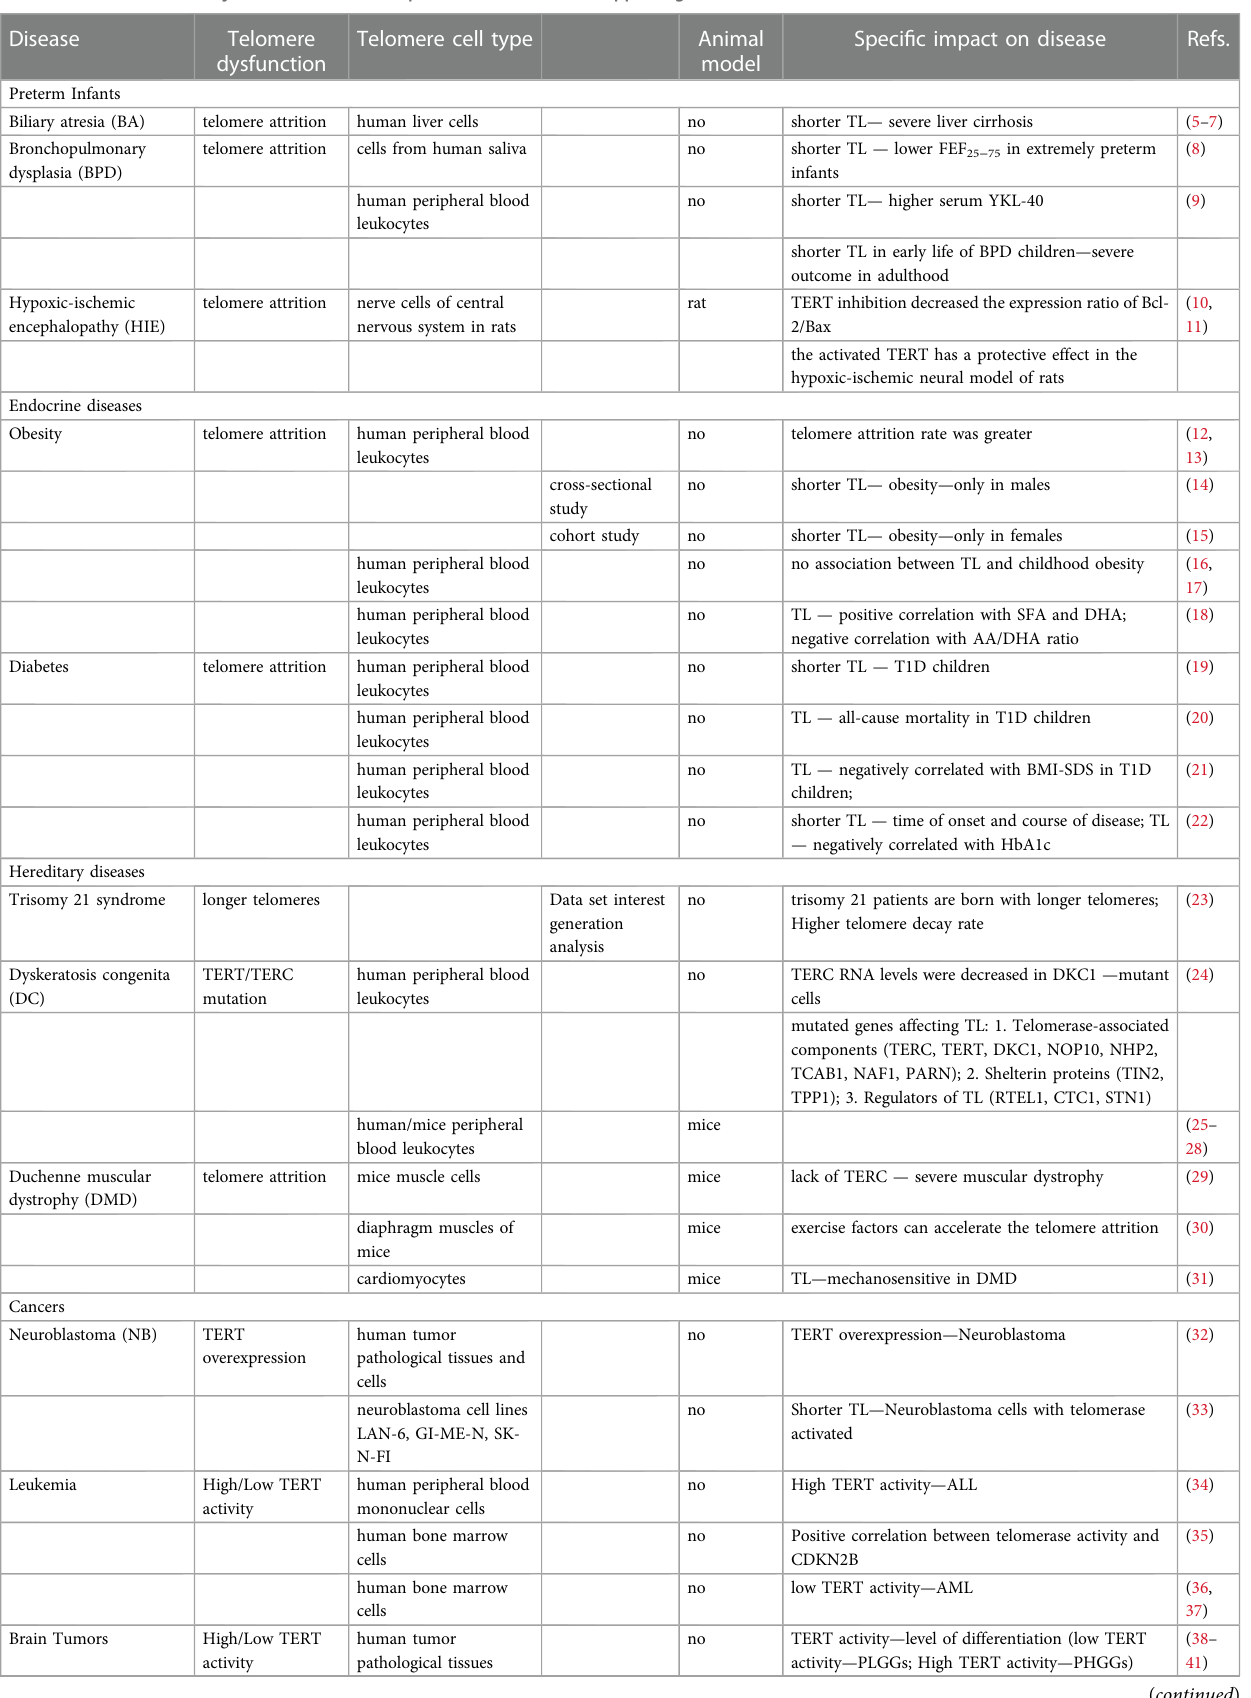
TABLE 1 List of telomere dysfunction-associated pediatric diseases and supporting evidence.